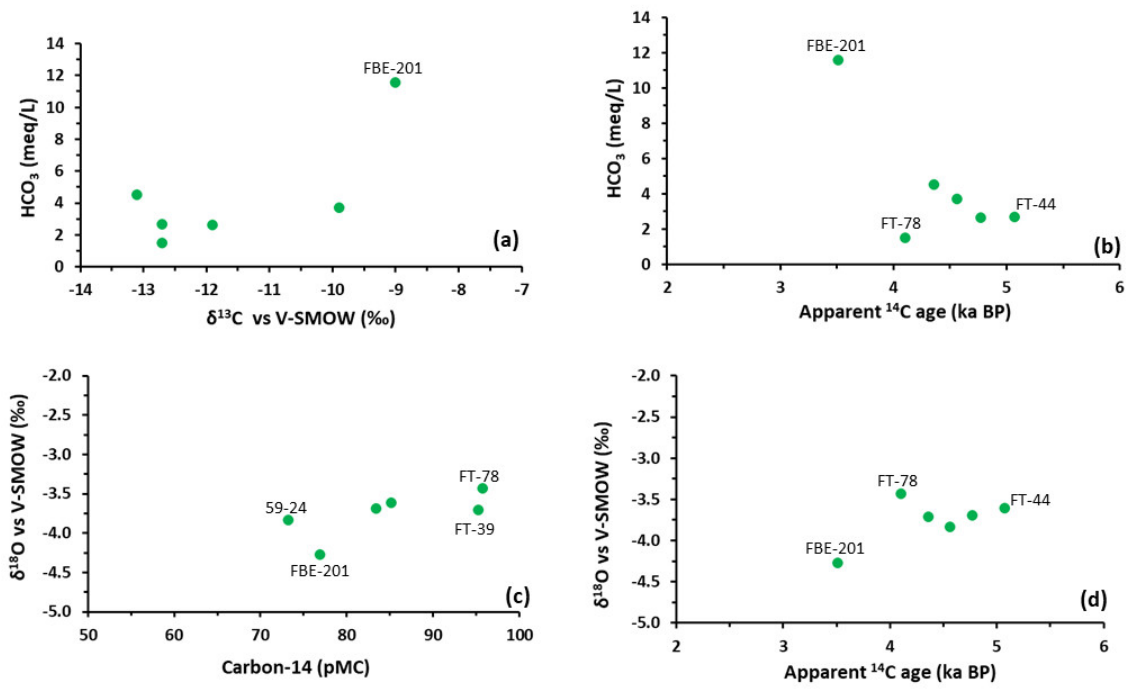
Figure 13. ( a ) HCO 3− vs. δ 13 C; ( b ) HCO 3− vs. Apparent 14 C age; ( c ) δ 18 O vs. Carbon-14; ( d ) δ 18 O vs. Apparent 14 C age.